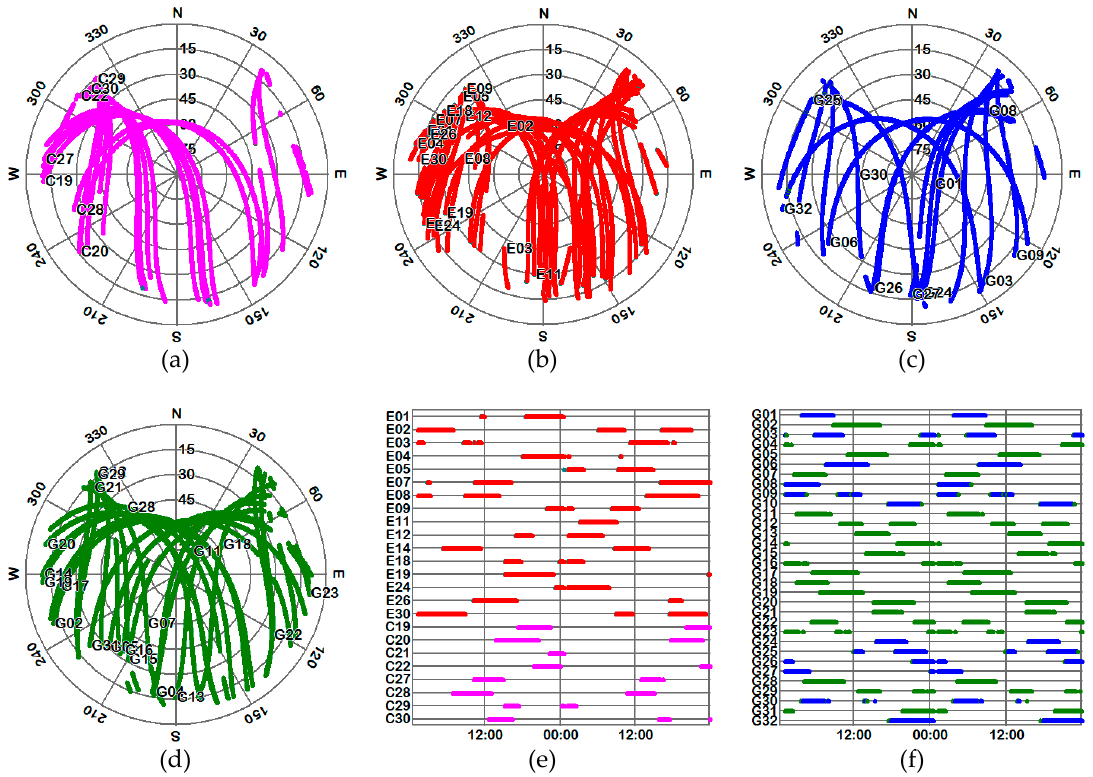
Figure 2. Sky plot of BDS-3 operational ( a ), Galileo ( b ), and GPS (Block IIF) ( c ); GPS (other Blocks) ( d ) satellites and their availability ( e , f ) from 3–4 June 2018 with 10° elevation cut-off